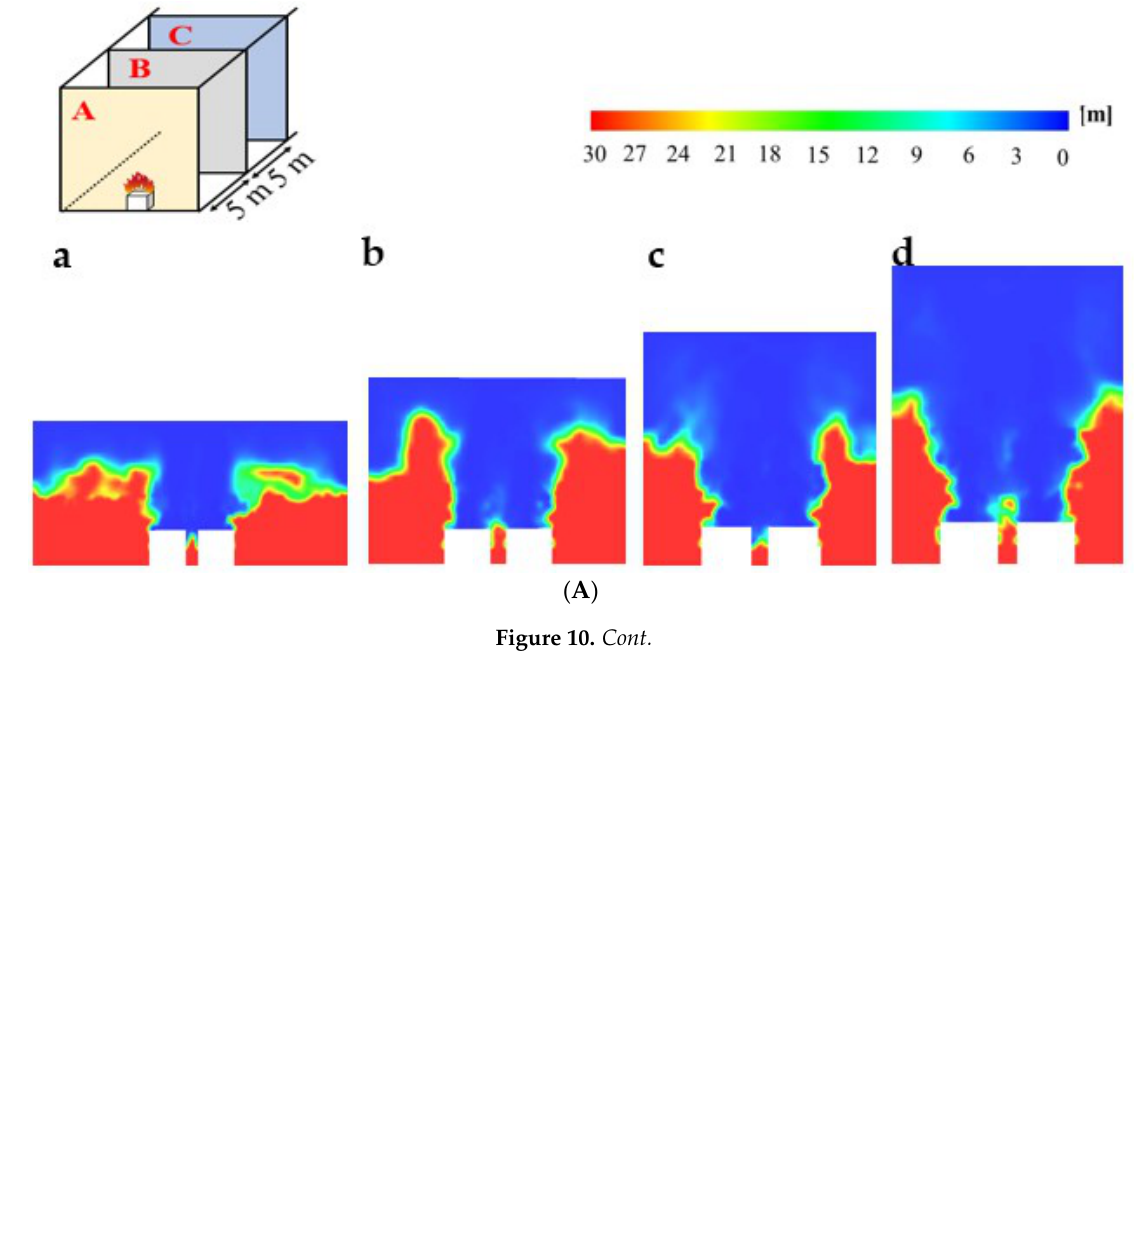
Figure 9. Critical velocity considering the aspect ratio of a tunnel with unsteady heat release